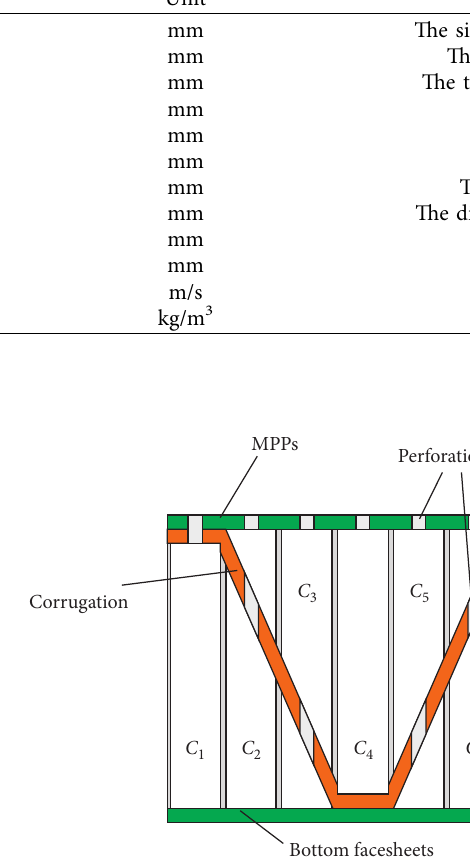
Figure 4: 2D model details of the whole